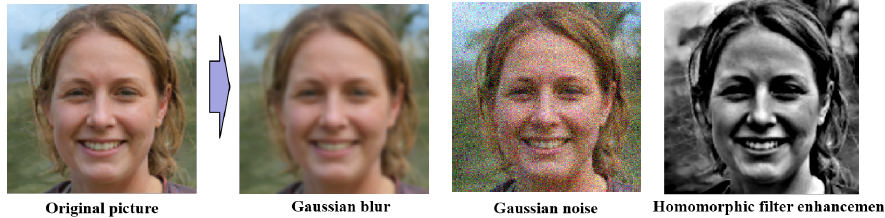
Figure 11. Face data preprocessing. In this figure, the fake face is from the open-source StyleGAN dataset.